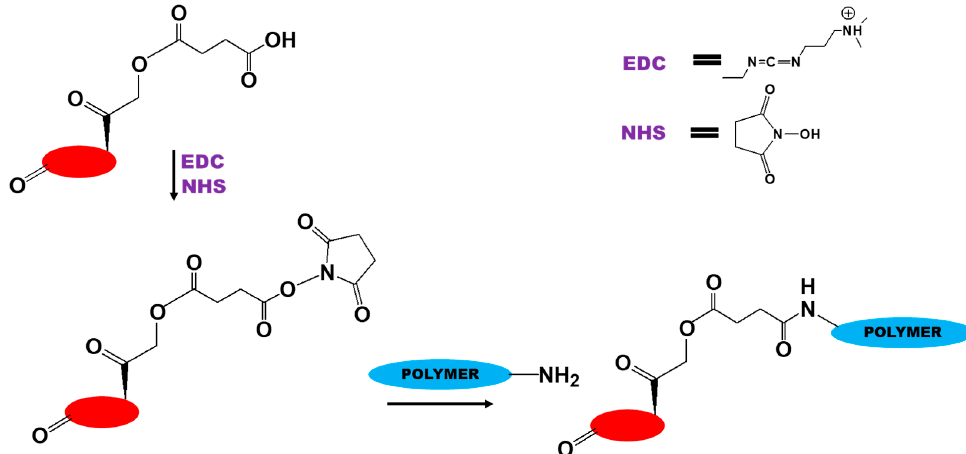
Figure 4. Scheme of conjugation of dexamethasone by carbodiimide chemistry.